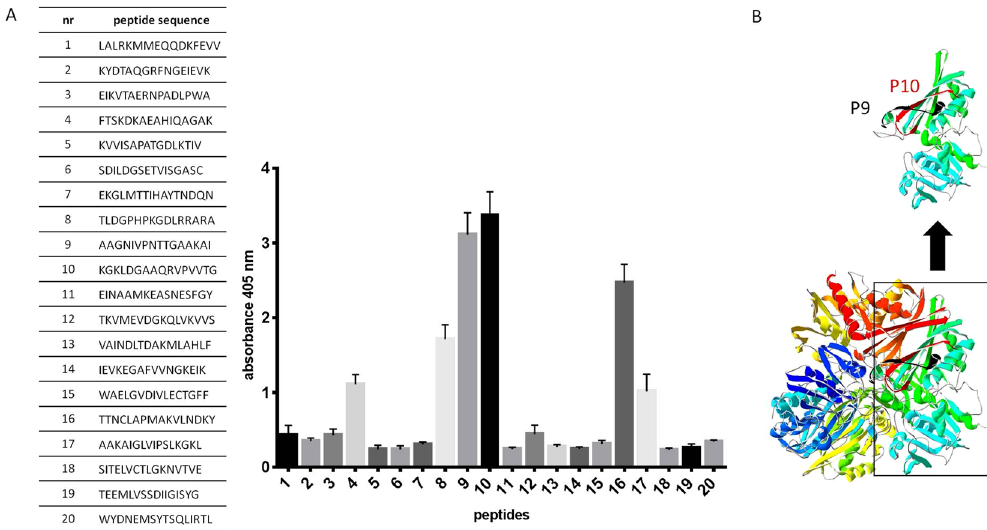
Figure 4. Results of epitope mapping using pooled sera from CDI patients (n = 10). ( A ) shows results of ELISA performed using peptides bound to the pins on 96 well plate. Primary antibody was detected by anti-human IgG-AP conjugated goat antibody which reacts with AP Yellow substrate. The result of colorimetric reaction was measured by reading absorbance in 405 nm. The figure shows results from three independent measurements, means with SD. ( B ) shows the localization of peptides P9 and